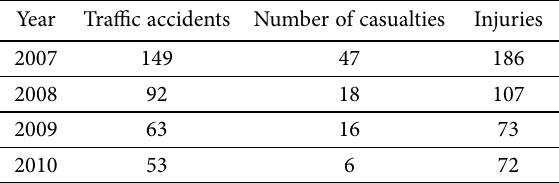
Table 4. Arrangement of speed gauges on the highway